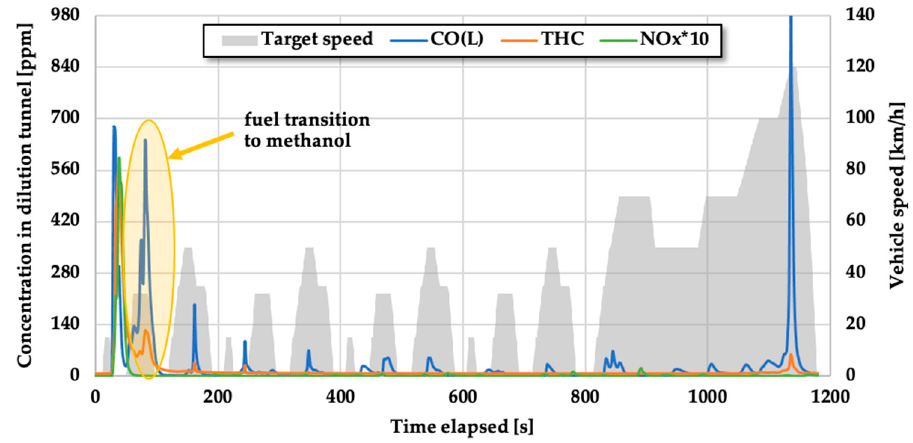
Figure 3. Modal concentrations of the regulated gaseous emissions in the dilution tunnel (Car #6).